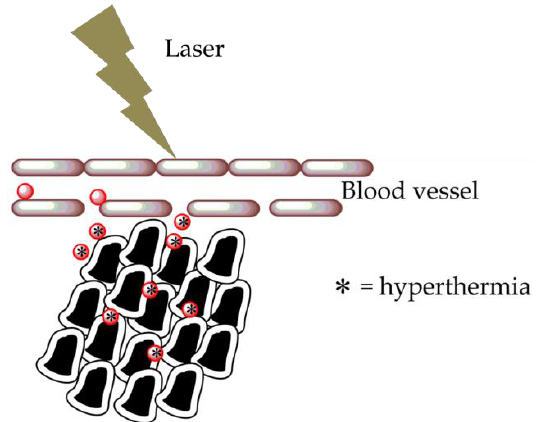
Figure 8. Hyperthermia cancer treatment using AuNPs. Nanoparticles carry a specific binder of the tumor, interacting with abnormal cells due to the implemented permeability of the vessels surrounding the cancer cells. Laser illumination of the AuNPs generates heat production.